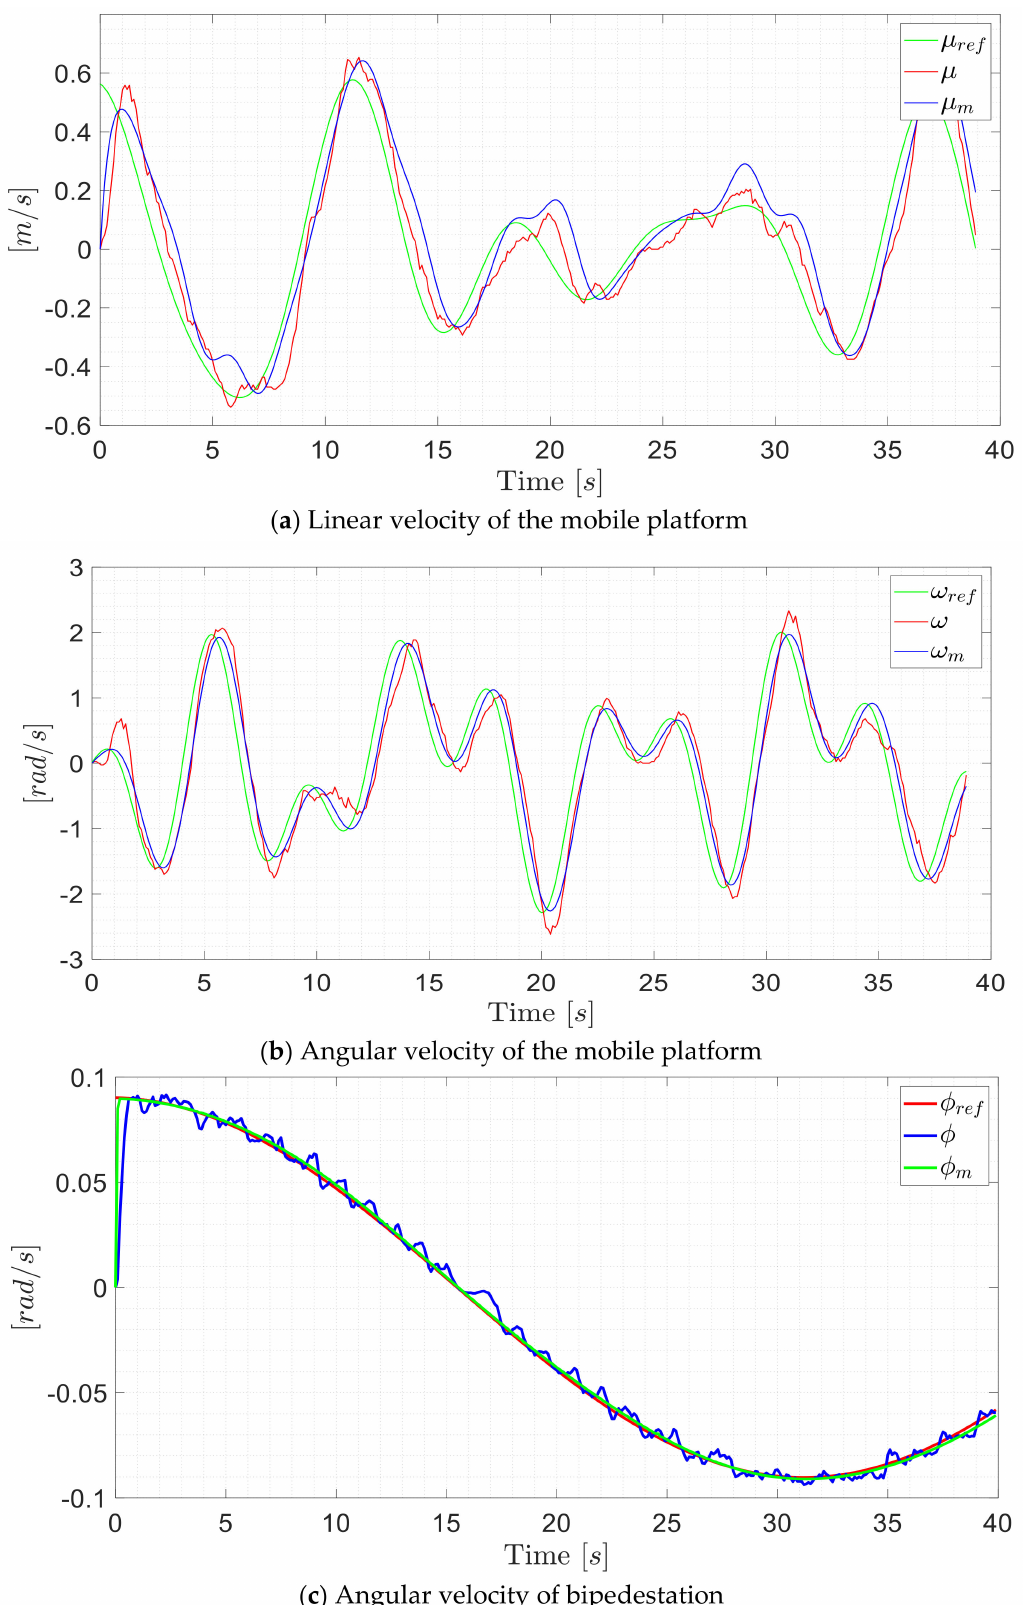
Figure 10. Validation data of the proposed dynamic model of the standing human–wheelchair. The subscript ref represents the excitation velocity to the robotic system; r represents the current velocity of the system; and m is the simulation velocity of the mathematical dynamic